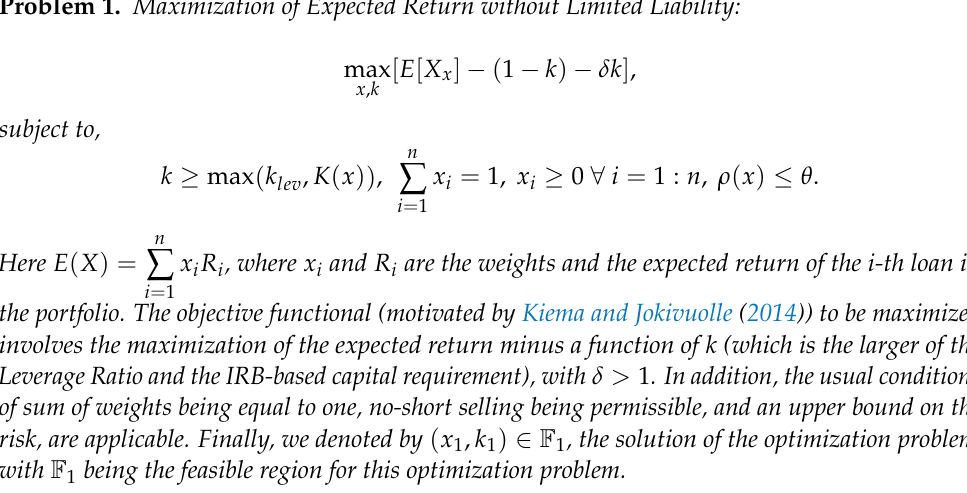
Table 2. List of symbols used in the model. Symbol Meaning k lev Leverage Ratio. K ( x ) Internal Ratings Based (IRB) Capital Requirement for the portfolio x . δ Opportunity cost of the capital (equity). X x Realizations for the loan portfolio x . ρ ( x ) Risk measure for the portfolio x (EL, UL etc.) µ Lower bound on Expected Return θ Upper bound on the